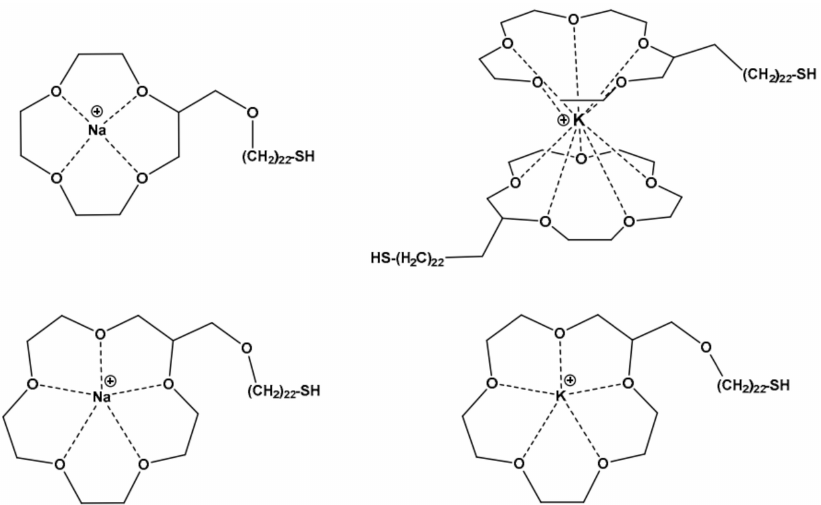
Figure 25. Au NPs functionalized via alkali crown ether. Reproduced with permission from refer- ences [178], ACS,